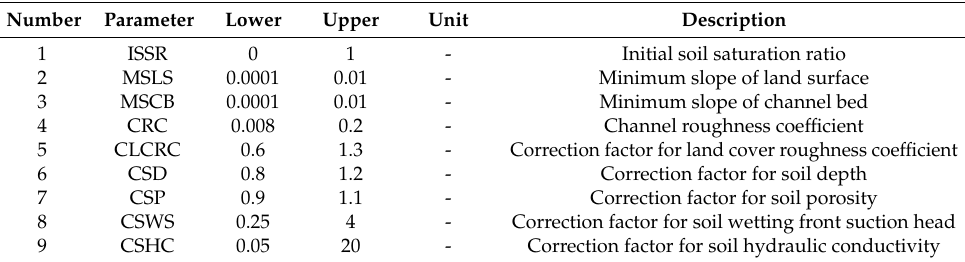
Table 2. Parameters of the GRM